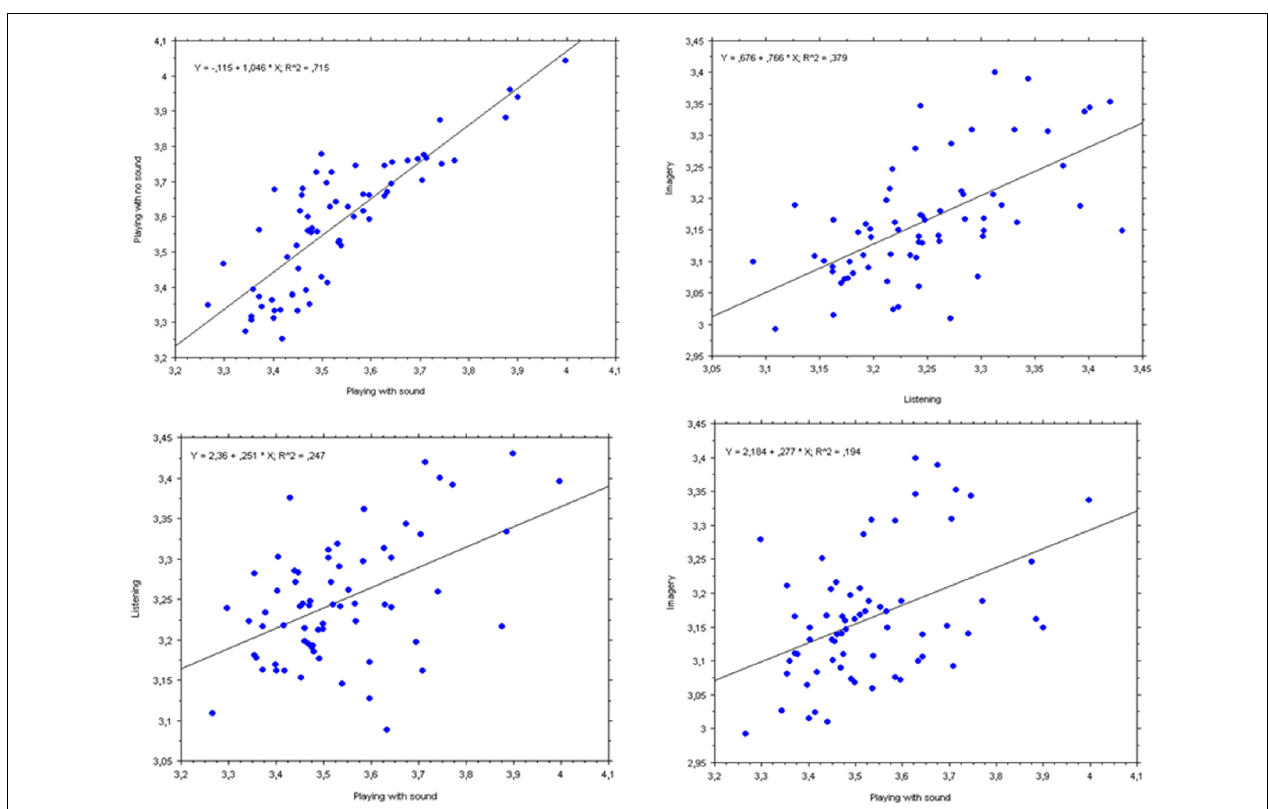
FIGURE 6 | Bivariate plots and simple regression lines for PP’s mean pupil diameters (in mm) for each measure of all three pieces together. Top left panel: dependent variable = “Playing with no sound”; independent variable = “Playing with sound”; Top right panel: dependent variable = “Imagery”; independent variable = “Listening”; Bottom left panel: dependent variable = “Listening”; independent variable = “Playing with sound”; Bottom right panel: dependent variable = “Imagery”; independent variable = “Playing with